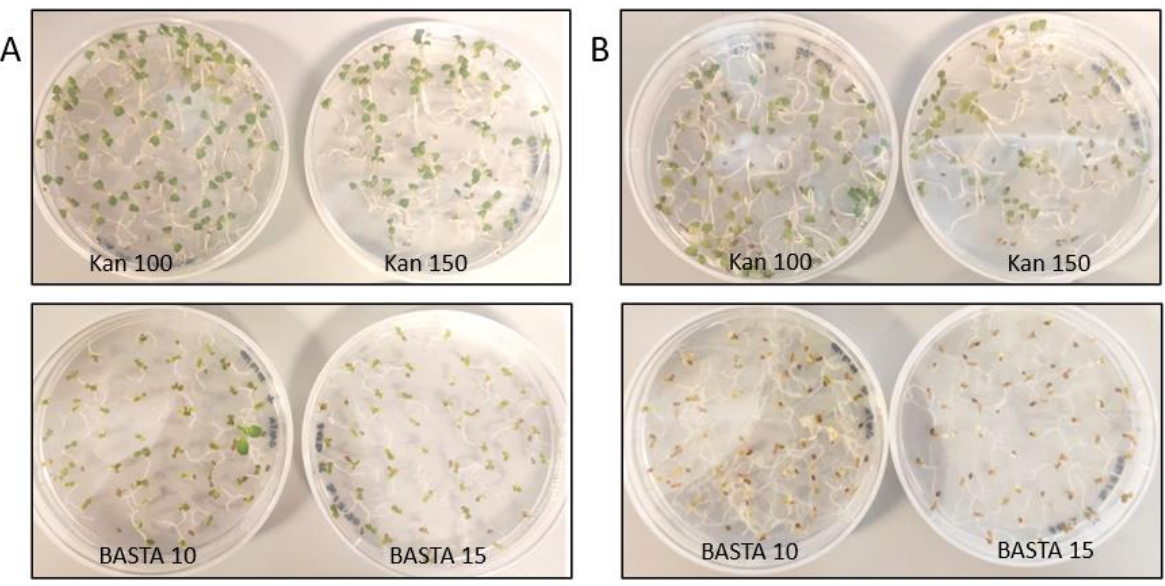
Figure 2. Kanamycin (Kan) and BASTA selection at higher doses. Selection of transgenic Camelina grown in vitro on MS media plates containing variable concentrations of antibiotic. Doses are expressed in mg/L. Picture taken after ( A ) 20 days growth, or ( B ) 30 days growth.